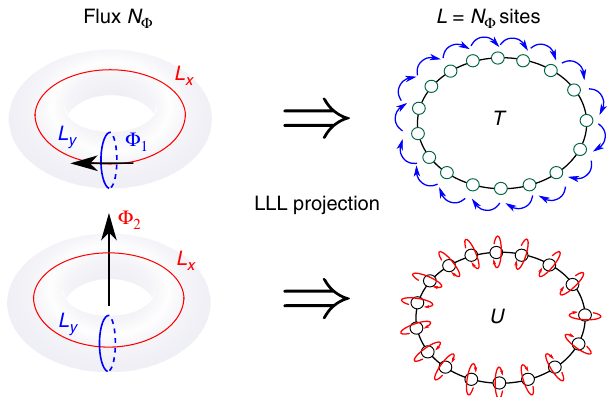
Fig. 1 LLL projection and fl ux insertion in the quantum Hall liquid. The LLL projection of a quantum Hall liquid on a torus maps the two-dimensional state into a one-dimensional ring of particles in orbital space. Inserting a fl ux quanta through one of the two cycles of the torus (depicted in red and blue) corresponds to a unitary operation that acts between the different ground states in the torus. In the one-dimensional representation, these unitary operations correspond to translation of the guiding centers by one orbital ( T ), or multiplication by a phase ( U ), depicted by blue and red arrows,